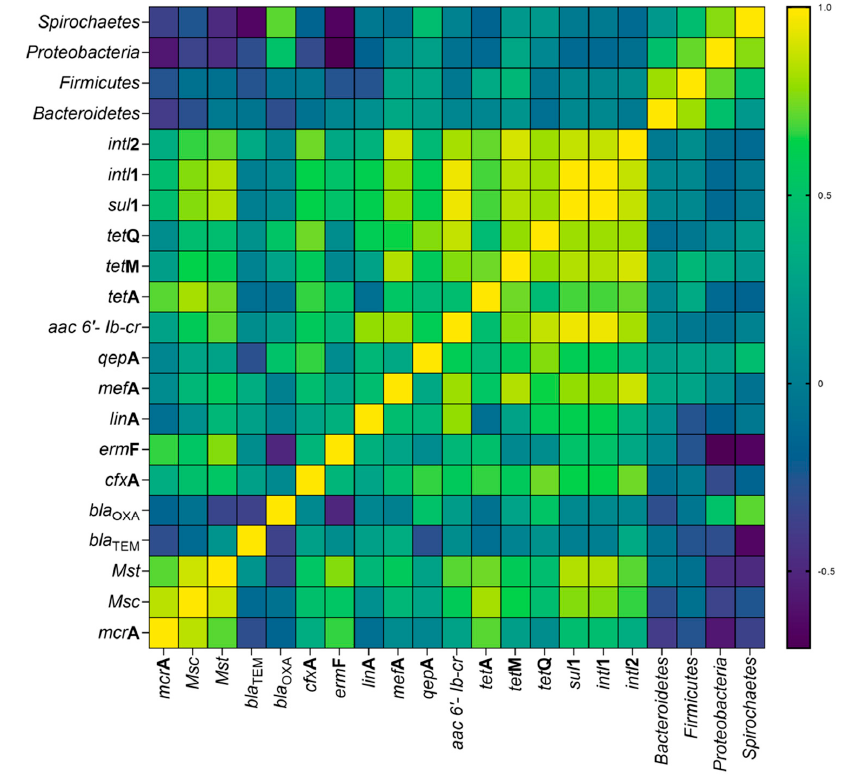
Figure 2. Spearman’s rank order correlation analysis between studied genes.